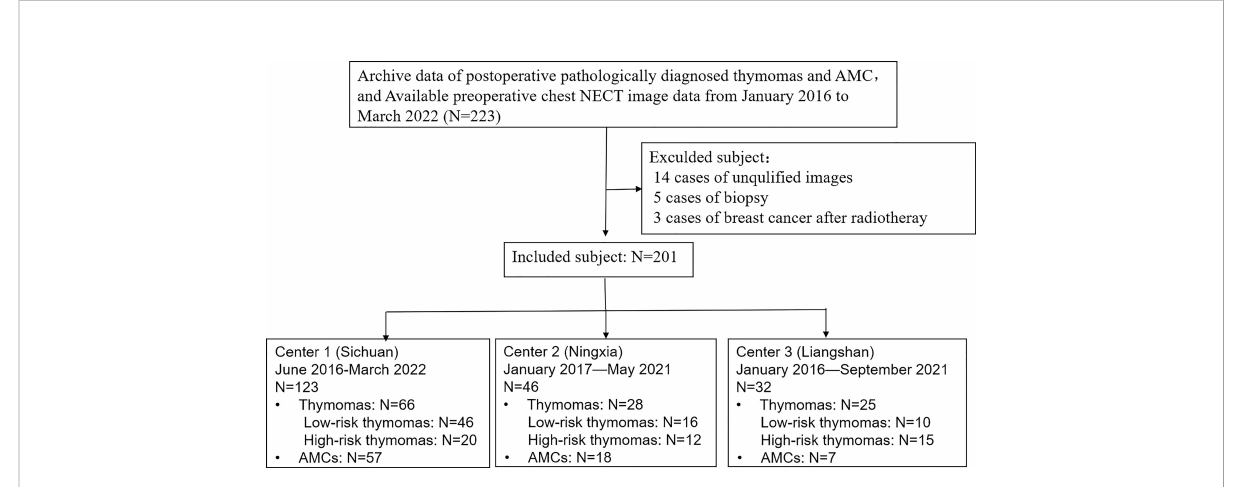
FIGURE 1 Flow diagram of subject